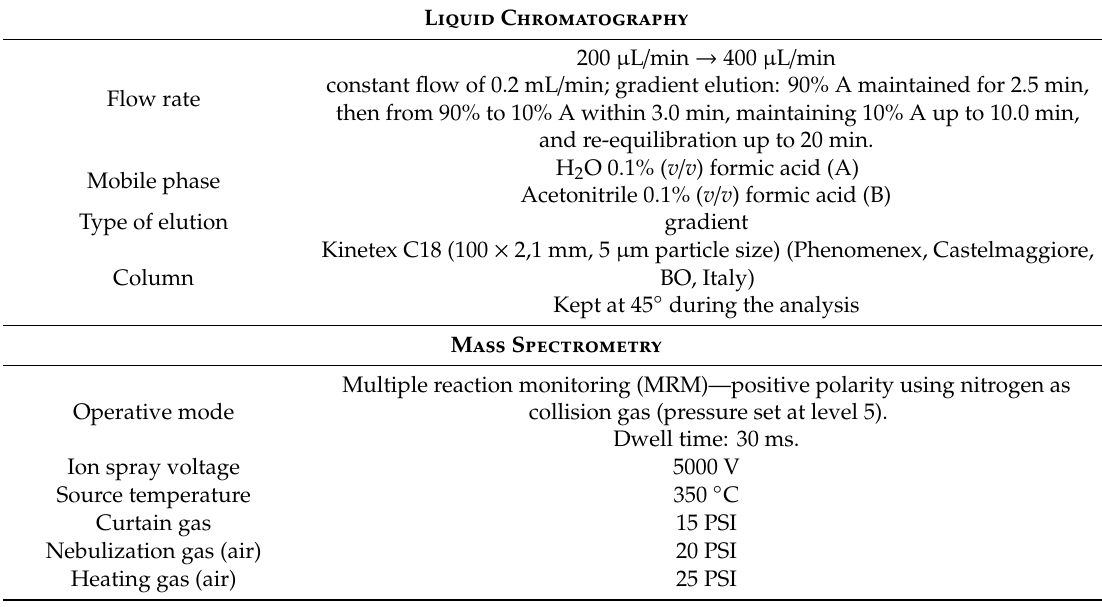
Table 6. Chromatographic conditions.